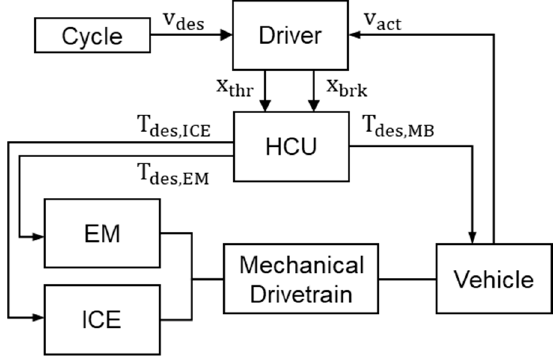
Figure 4. Modular structure of the system simulation model and exchanged quantities.